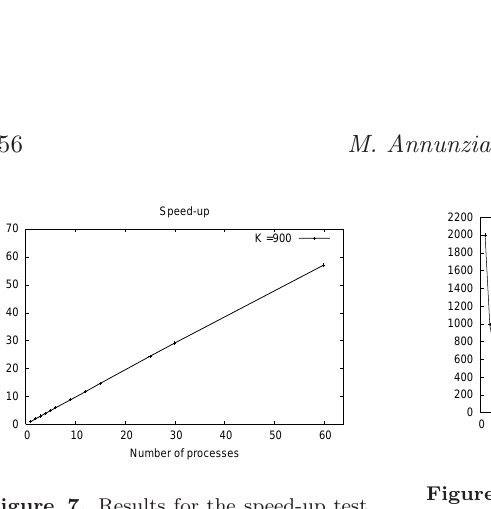
Figure 7. Results for the speed-up test for the McFadden problem with 900 spa- tial mesh points.